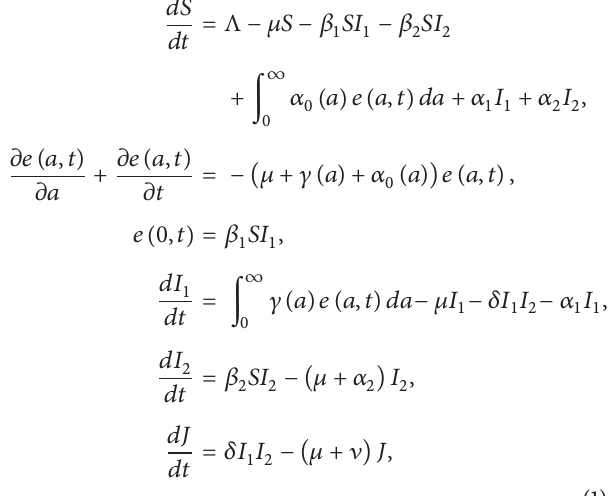
Figure 1: The flow diagram of the model (1). Two yellow rectangu- lars denote the individuals infected by latent tuberculosis and active tuberculosis. The red rectangular denotes the individuals infected by HIV. The orange rectangular denotes the individuals coinfected by TB and